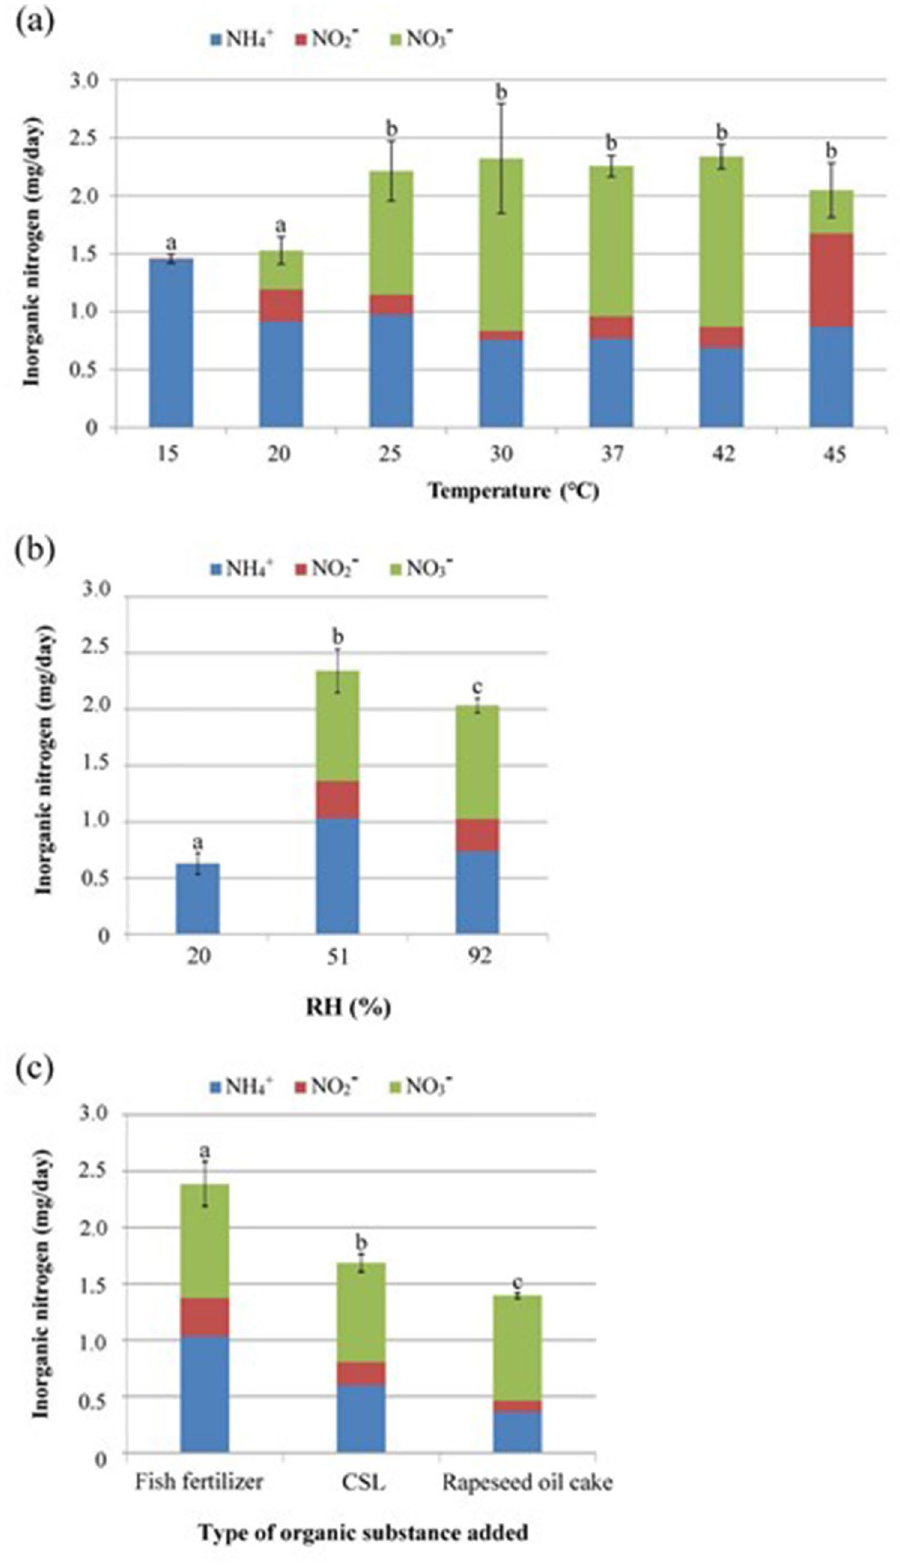
Figure 4. Determination of optimal conditions for N mineralization in the leachate from rockwool treated with organic substances. Bars labelled with the same letter do not differ significantly (Fisher’s protected LSD test, P < 0.05). ( a ) Effect of incubation temperature on N mineralization with fish fertilizer. We measured the composition of inorganic N in the leachate following incubation at the indicated temperatures. Values are means ± SD ( n = 3). ( b ) Effect of relative humidity (RH) during incubation on N mineralization with fish fertilizer. We incubated the inoculated carriers at the indicated RH and measured the composition of inorganic N in the leachate. Values are means ± SD ( n = 3). ( c ) Effect of organic substance type on N mineralization. Values are means ± SD ( n =